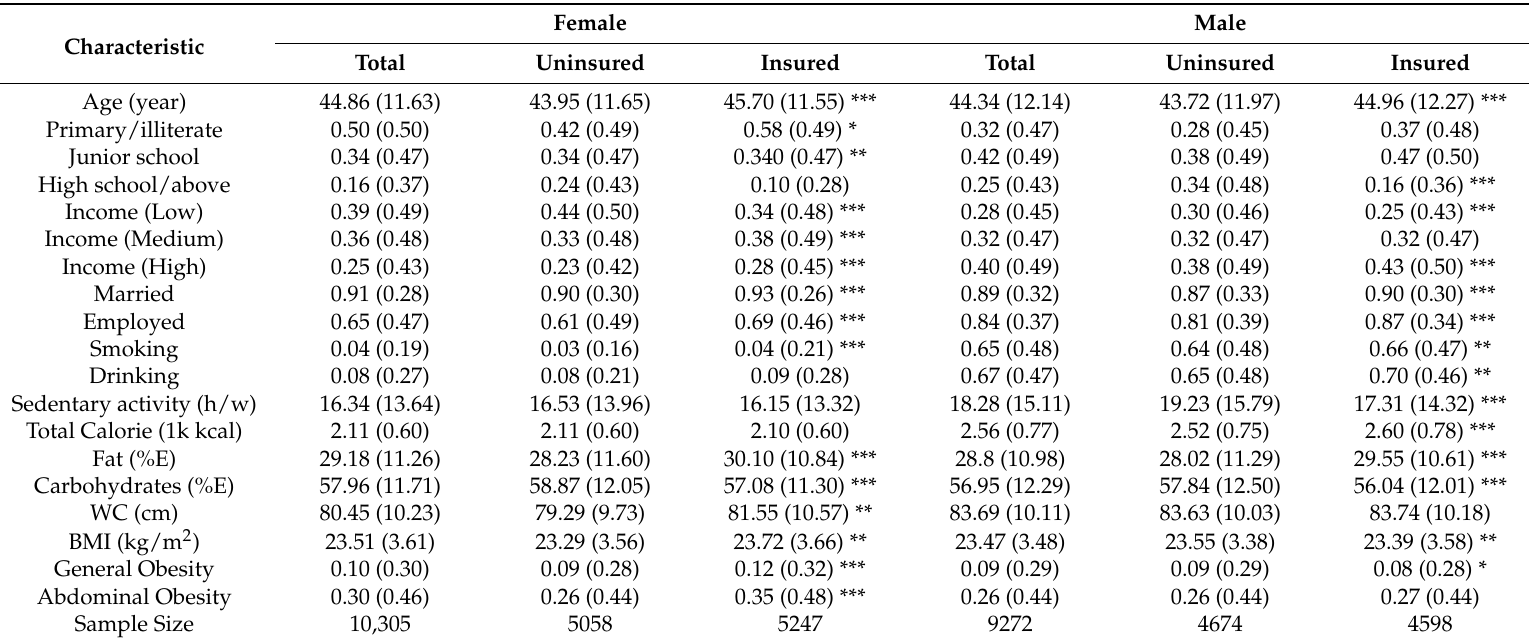
Table 1. Basic characteristics of the health insurance status in different gender